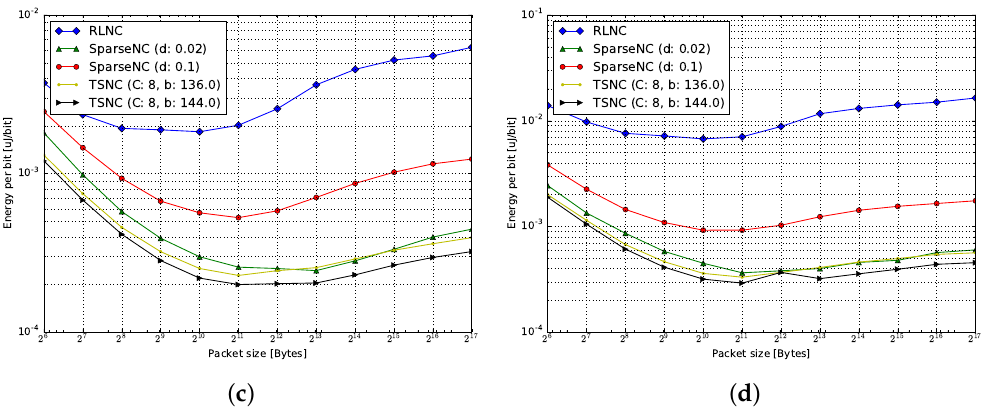
Figure 10. Encoder energy measurements for the Raspi 2. ( a ) Energy per bit vs. generation size for q = 2; ( b ) energy per bit vs. generation size for q = 2 8 ; ( c ) energy per bit vs. packet size for q = 2, g = 128; ( d ) energy per bit vs. packet size for q = 2 8 , g = 128.